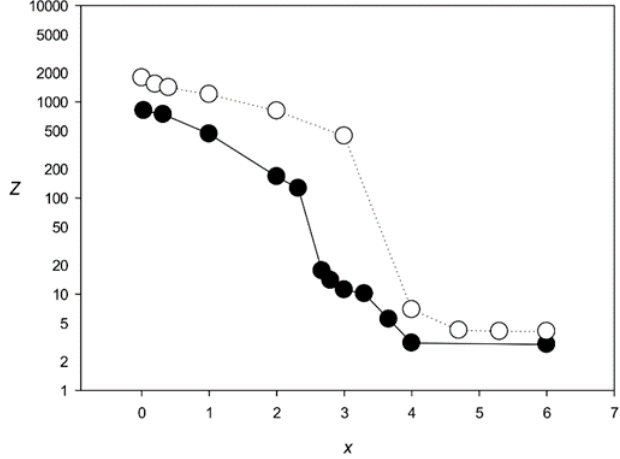
Figure 7. Z ( x ) for MSAs produced by the MAHDS algorithm. Black circles, 100 sequences with 50 indels; white circles, 500 sequences with 250 indels.